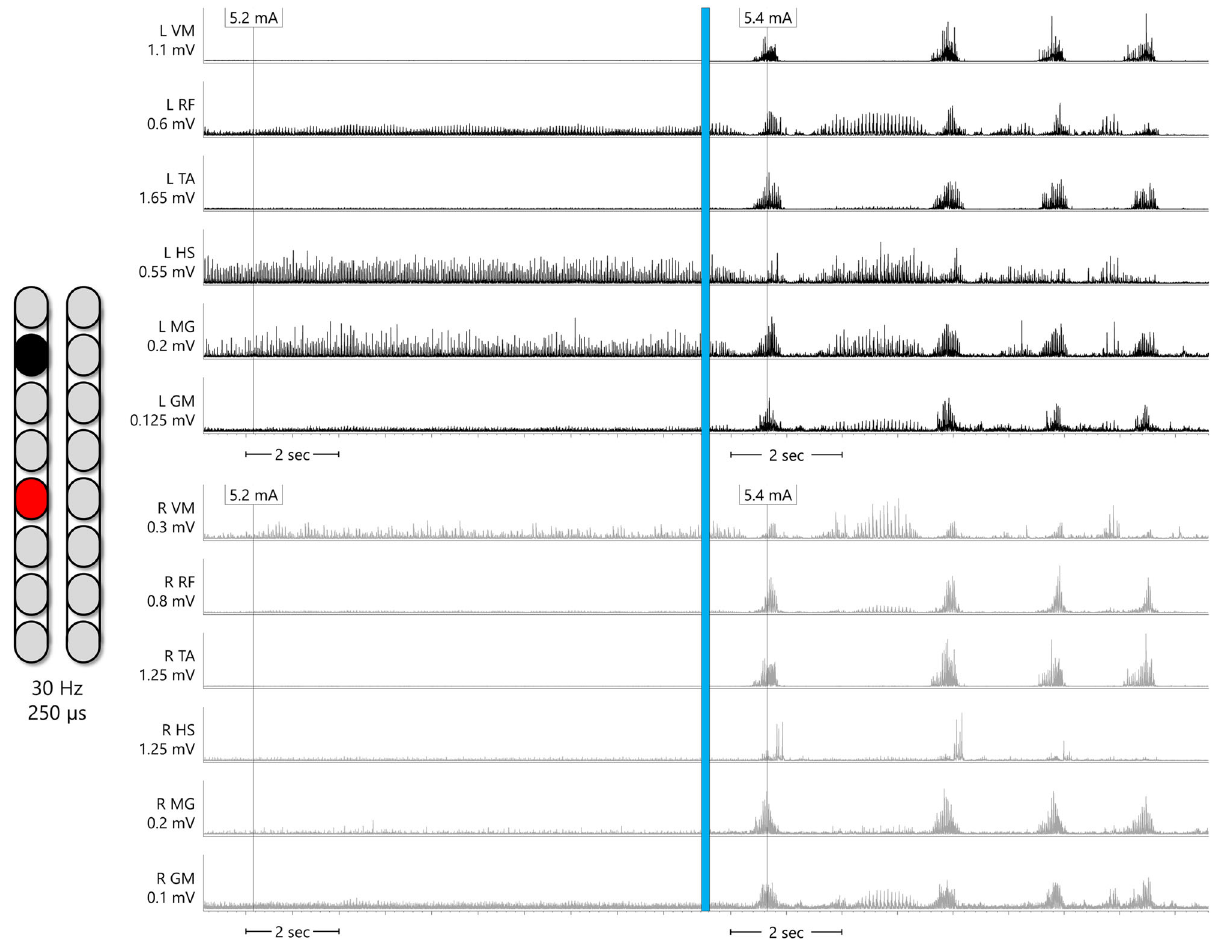
Fig. 2 | Supine rhythmic EMGs. Example electromyograms (EMGs) of left leg muscles(blacktraces)andrightlegmuscles(graytraces)whileSCESisdeliveredin supineatvariousamplitudestoparticipant0773,usingthecon fi gurationshownon the left of the fi gure (black is the cathode and the red is the anode). In the left columnofEMGs,SCESdeliveredat5.2mAinduceslittletonicactivityornoactivity at all. In the right column of EMGs, the same SCES con fi guration is delivered at 5.4mA. Upon ramping of stimulation to 5.4mA, a single burst of activity across